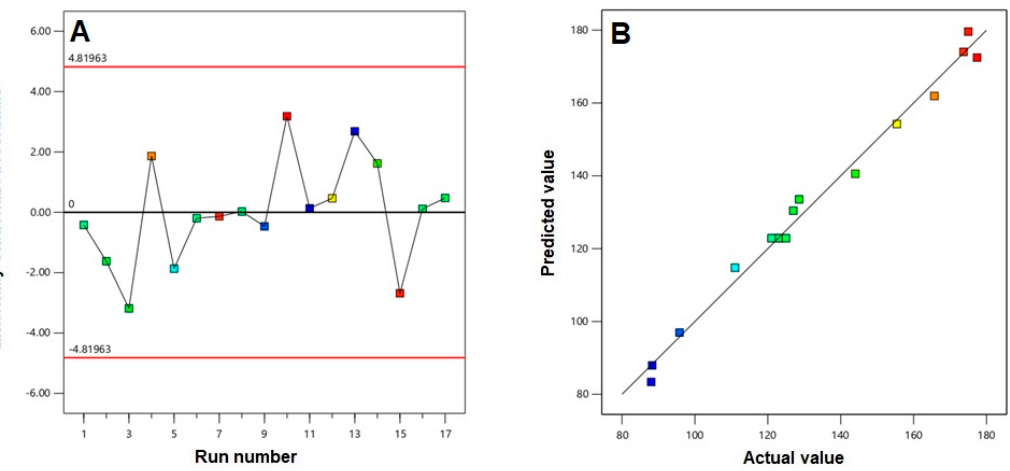
Figure 1. Diagnostic plots for flibanserin (FLB) transfersome (TRF) vesicle size: ( A ) externally studentized residuals vs. run number plot; ( B ) predicted vs. actual values